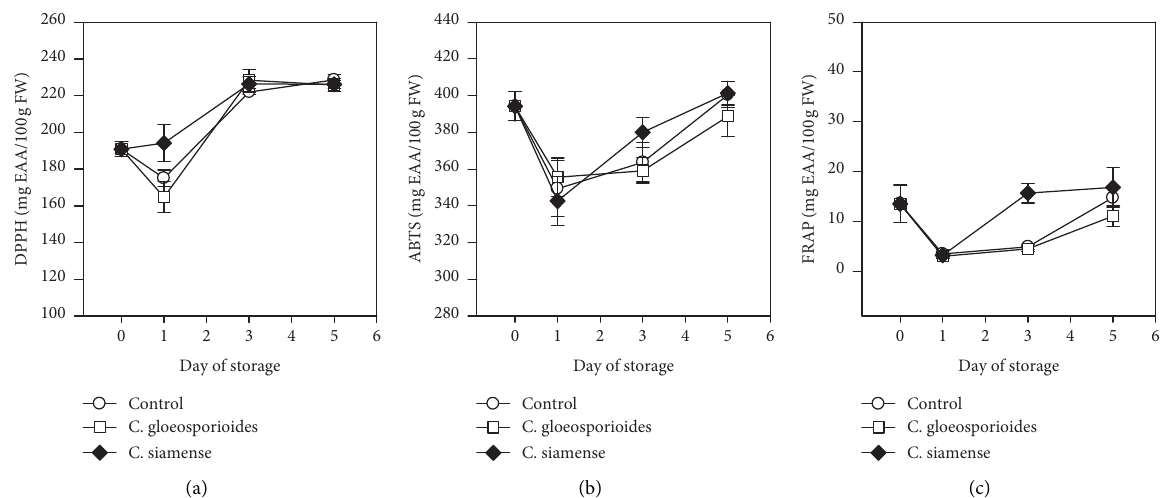
Figure 4: Antioxidant activity by the DPPH method • (a), antioxidant activity by the ABTS • + (b), and antioxidant activity by the FRAP method (c) in soursop fruits with three different treatments. Control ( C ), C. gloeosporioides , and C. siamense